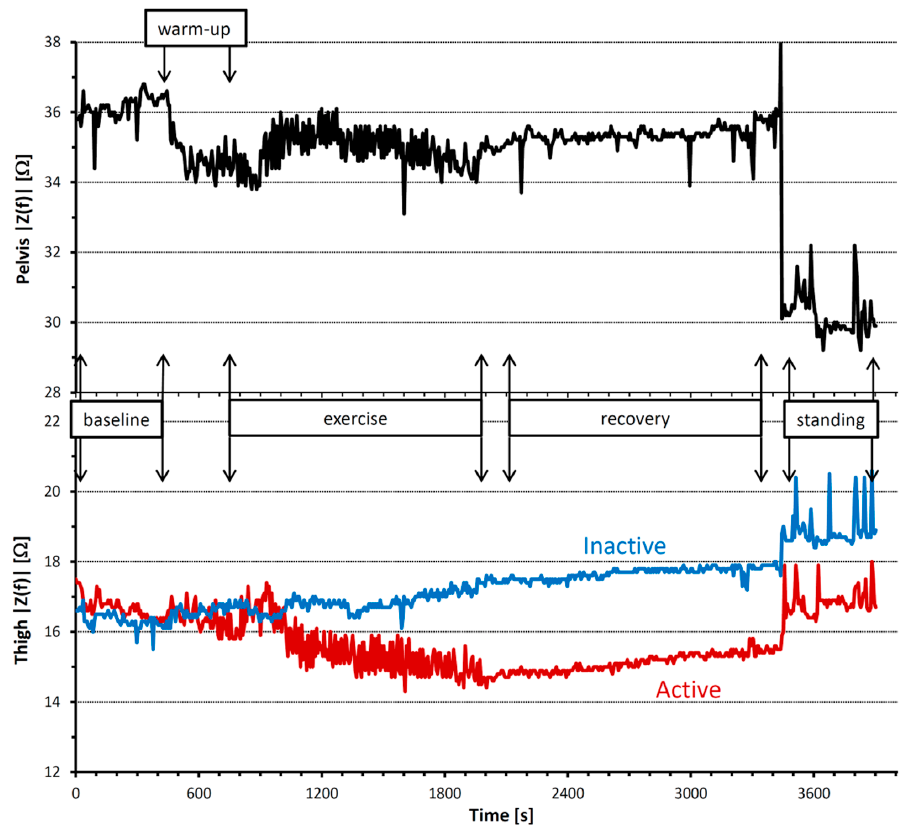
Figure 5. Profiles of |Z (f) | at f = 48 kHz in the pelvis area ( upper panel ) and in the active (red) and inactive (blue) thighs ( lower panel ) during the whole experimental session. Please note that the selected subperiods corresponding to “exercise”, “recovery” and “standing” conditions are spaced by a few minutes to exclude transitions phases from the analysis.